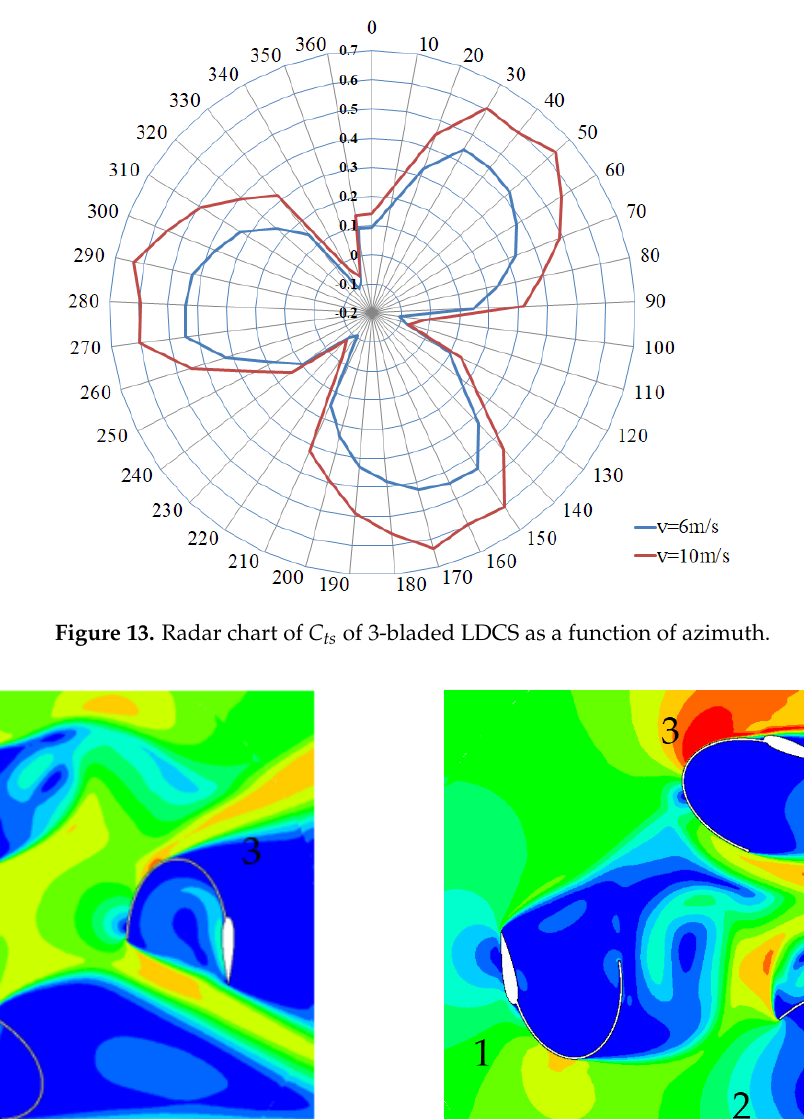
Figure 14. Velocity magnitude of 3-bladed LDCS ( U = 6 m/s): ( a ) θ = 30°: ( b ) θ = 100°.